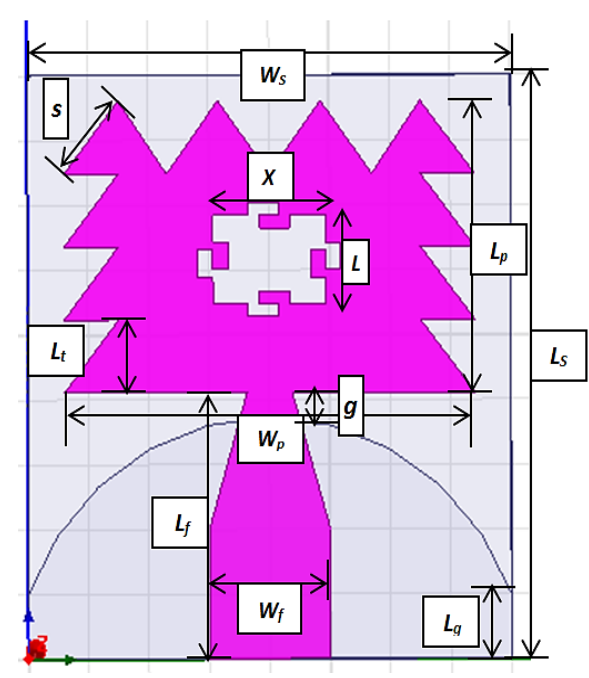
Figure 4: Geometrical view of model 4